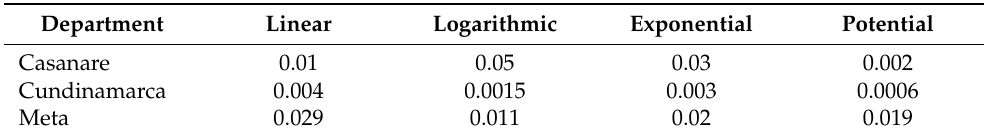
Table 2. R 2 value correlates MRW and average travel speed between villages and districts with their municipal capital.